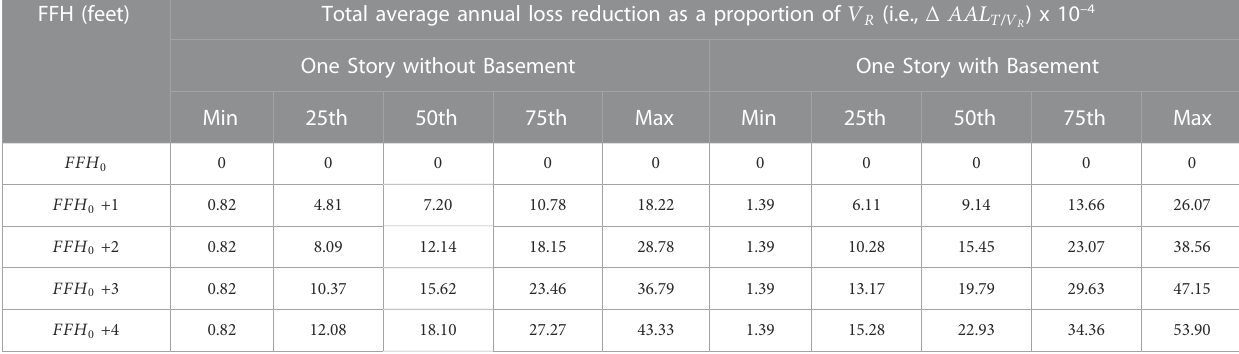
TABLE 7 Annual fl ood risk reduction by FFH elevation for one-story single-family home with and without basement using synthetic data. FFH